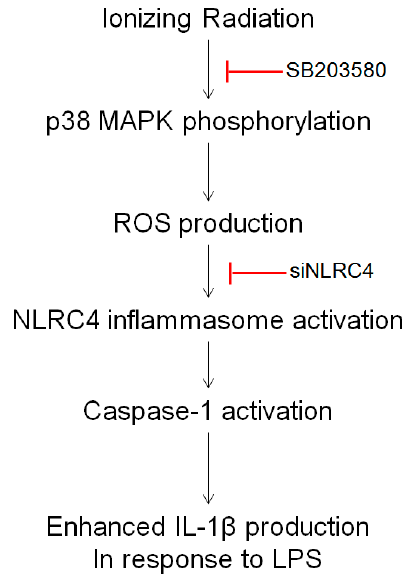
Figure 8. Proposed model for the molecular mechanism of IR-enhanced LPS-stimulated IL-1 β production in RAW264.7 macrophage cells.